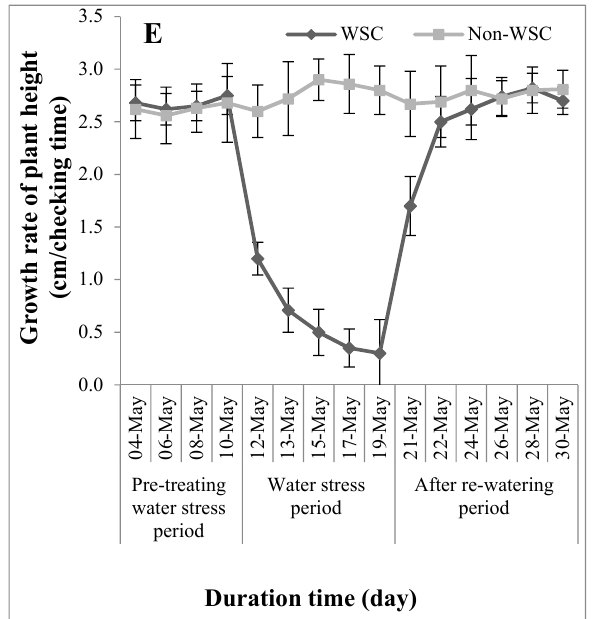
Figure 1. Growth rate of the plant height of Ehretia asperula in response to biochar treatments in concentrations of 0 ton ha − 1 ( A ), 5 tons ha − 1 ( B ), 10 tons ha − 1 ( C ), 15 tons ha − 1 ( D ), and 20 tons ha − 1 ( E ) under the non-WSC and WSC. Vertical bars represent mean ± SD, n = 15.